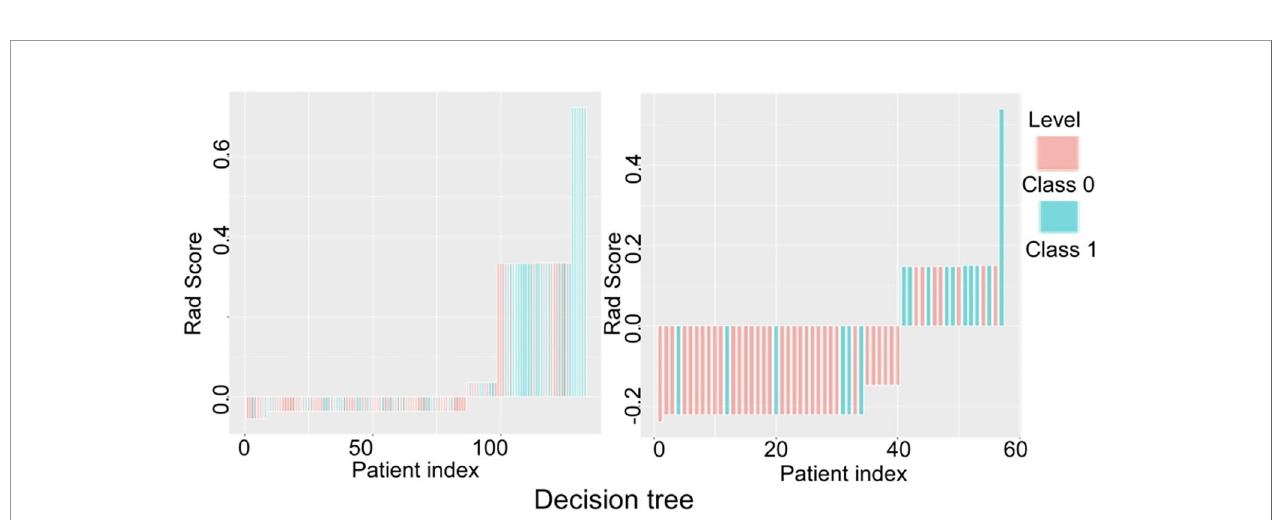
FIGURE 7 | Veri fi cation and comparison of the decision tree model in predicting low and high grade renal cell carcinoma in the training and testing set. In the training set, the true negative rate (speci fi city) was 77.8% (63/81) for predicting grade I-II clear cell renal cell carcinoma (ccRCC), and the true positive rate (sensitivity) was 55.8% (29/52). In the testing set, the true negative rate was 82.9% (34/41) for predicting grade I-II ccRCC and 62.5% (10/16) for predicting grade III-IV